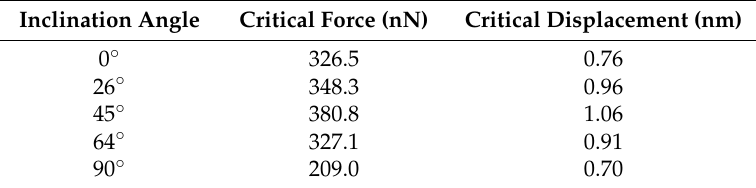
Figure 5. Force–displacement curves of twinned Al containing TBs with different inclination angles under nanoindentation. Table 1. Critical force and displacement for different inclination